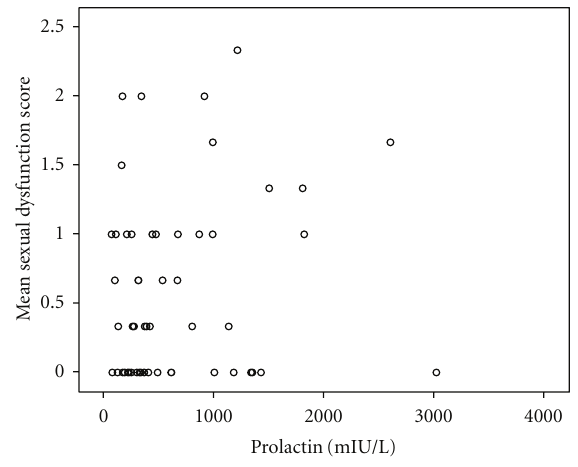
Figure 2: Sexual dysfunction and serum prolactin levels. Notes. Mean sexual dysfunction score = Composite mean sexual dysfunc- tion score calculated based on the UKU-SERS Pat items Diminished sexual desire; Erectile dysfunction; and Ejaculatory